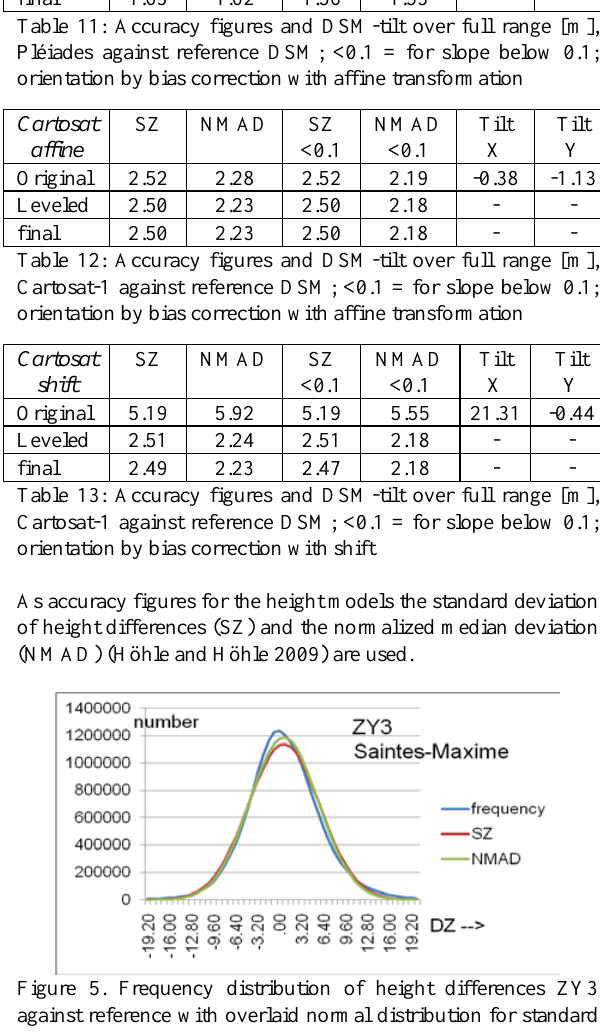
Figure 9. Systematic height errors in X-direction, Saintes-